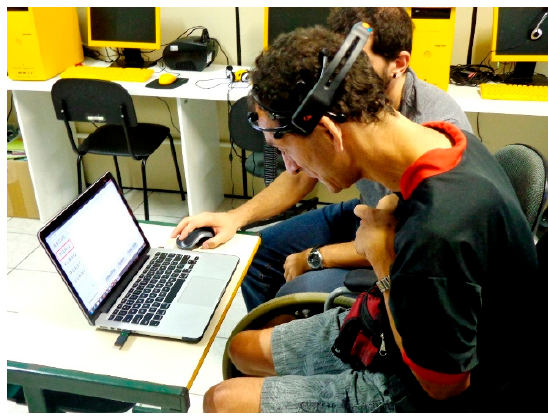
Figure 4. User A interacting with the system. Credit by Record News Santa Catarina. Table 3. Performance of the pedagogue.